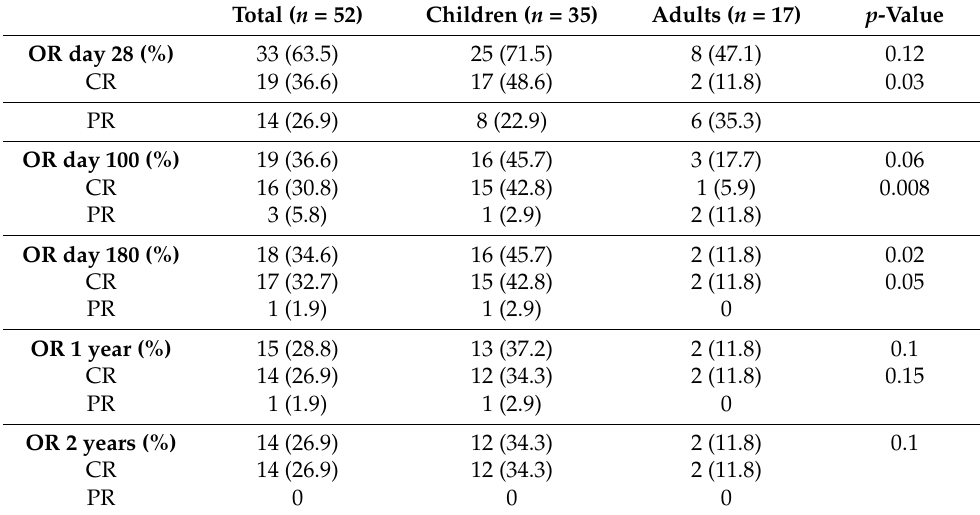
Table 2. Overall response to MSC infusion according to the groups.